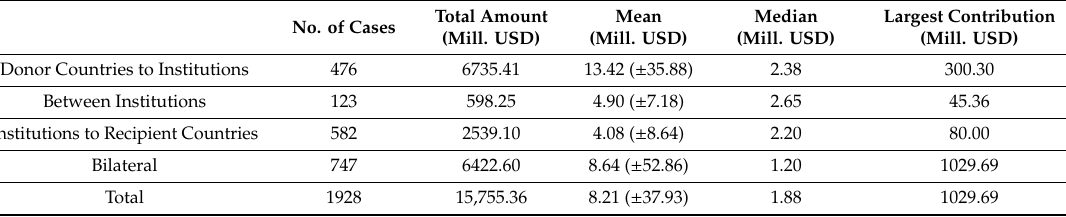
Table 1. REDD + financial commitments between 2006–2015 (Data source: Food and Agriculture Organization (FAO),